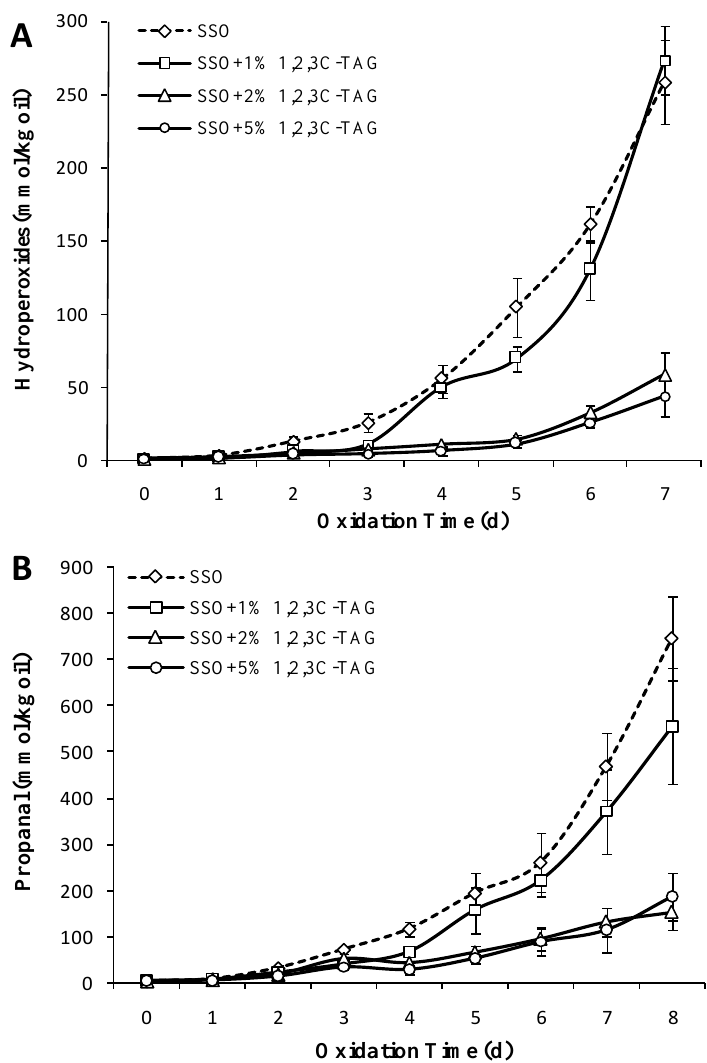
Figure 6. Effect of different concentrations of caprylic triglyceride (1,2,3C-TAG) structured lipids on the content of POV ( A ) and propanal ( B ) in SSO (50 °C).